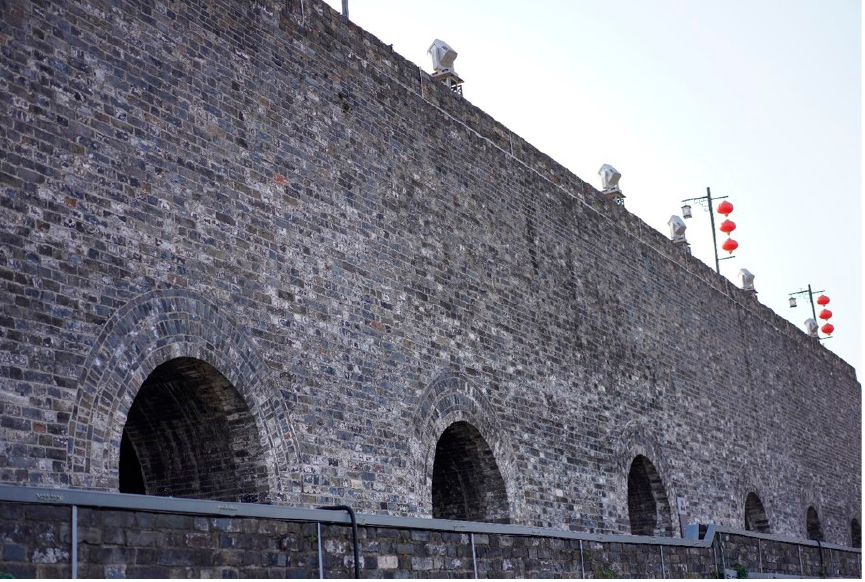
Figure 1. Part of the Nanjing City Wall.